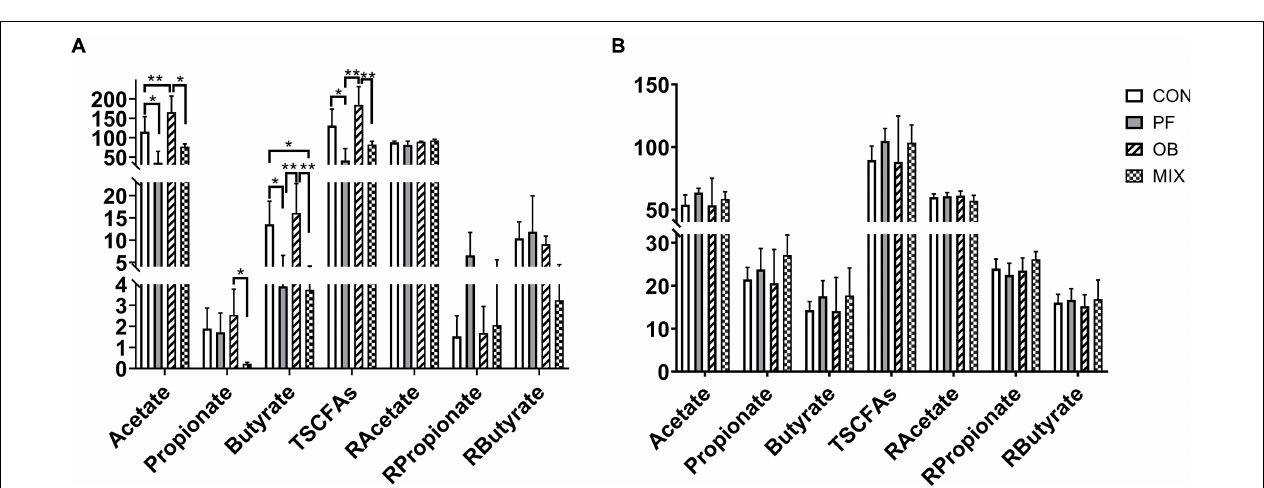
FIGURE 3 | The concentration and proportion of SCFAs in the ileal and colonic digesta of pigs in different groups. (A) The concentration and proportion of SCFAs in the ileum of the pigs. (B) The concentration and proportion of SCFAs in the colon of the pigs. * p < 0.05, ** p < 0.01. CON, control group; PF, 15% pea-hull fiber in the diet; OB, 15% oat bran in the diet; MIX, 7.5% pea-hull fiber and 7.5% oat bran in the diet; TSCFAs, total SCFAs; R, ratio of each SCFA to